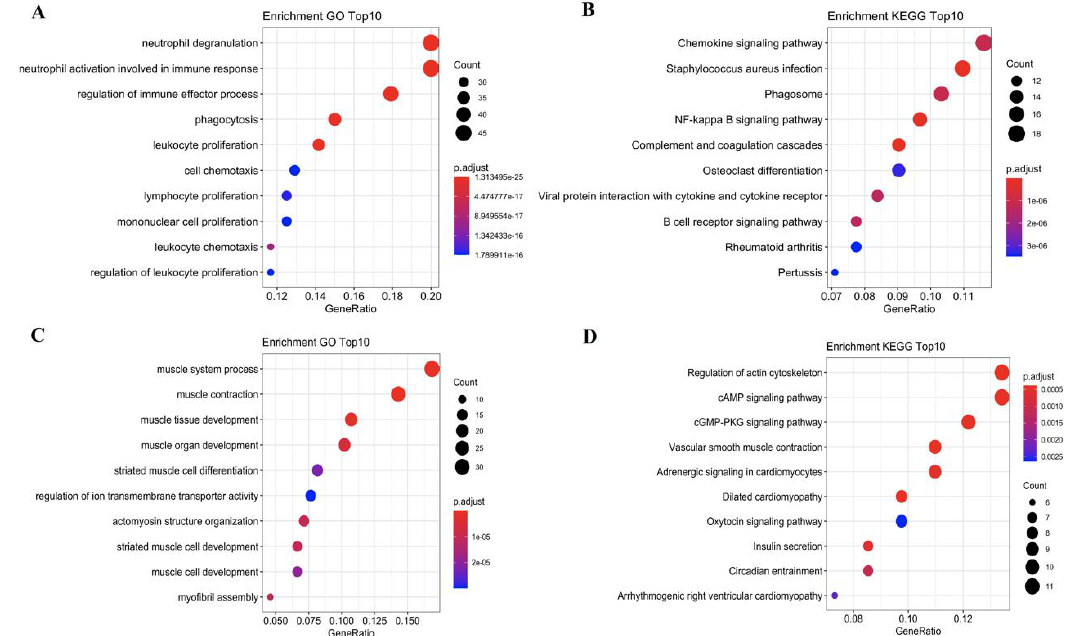
Figure 2. The functional enrichment analysis of common upregulated and downregulated genes using GO and KEGG analysis. ( A , B ) The top 10 enrichment pathways of 259 common upregulated genes using GO and KEGG analysis, respectively. ( C , D ) The top 10 enrichment pathways of 218 common downregulated genes using GO and KEGG analysis, respectively. The sizes of the dots represent the counts of enriched genes, and the dot color represents the adjusted p -value. Table 2. The detailed annotation of key genes based on MGI and GWAS Catalog databases.